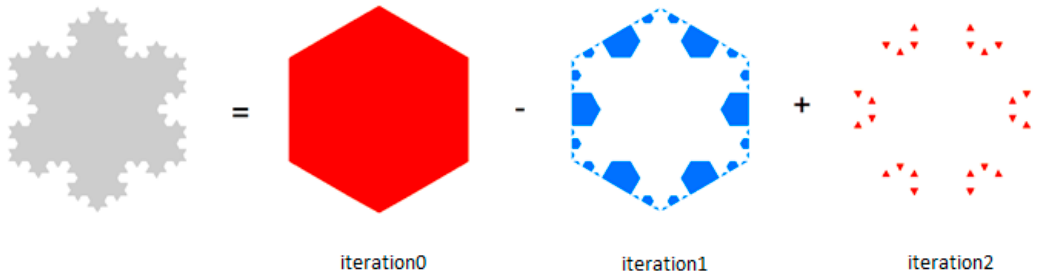
Figure 2. (Color online) Illustration of geometric measures for the ( a ) point-based simplifying unit (e.g., Douglas–Peucker (DP) algorithm) and ( b ) areal-based unit (e.g., bend simplify (BS) and hierarchical decomposition of a polygon (HD) algorithm).